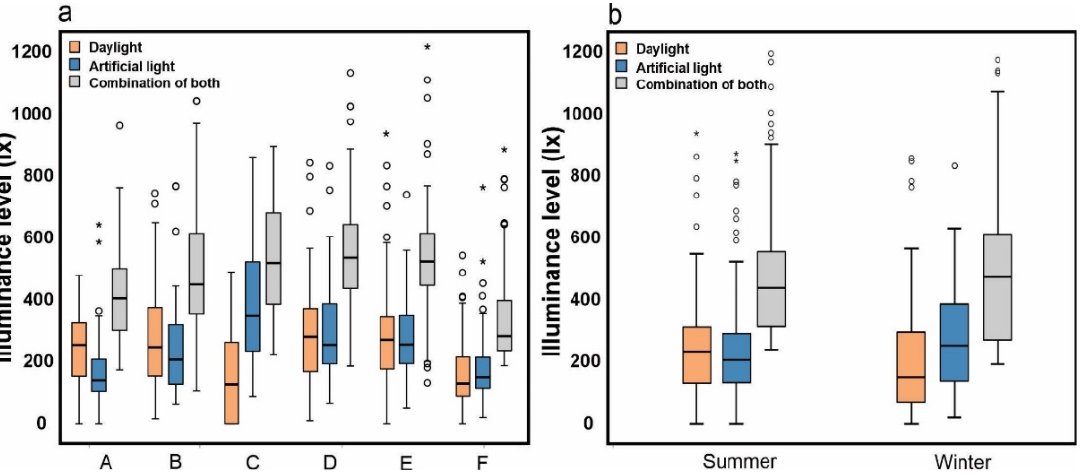
Figure 2. On-site measured illuminance in the studied buildings. Separated by building ( a ) separated by season ( b ). Extreme outliers are marked with an asterisk and circles.